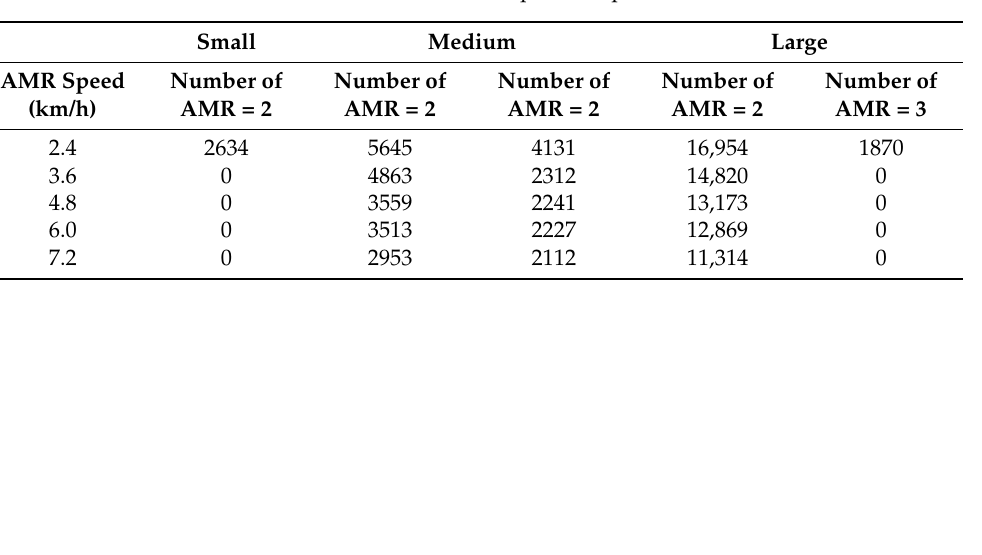
Table 1. Values of tardiness as a function of the AMR speed—separated handover